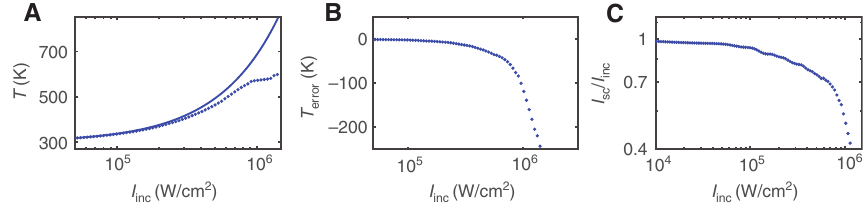
Figure 4: Temperature and intensity for intense on-resonant illumination ( λ = 671 nm). Same as in Figure 2 for the on-resonance case ( λ = 671 nm and ε